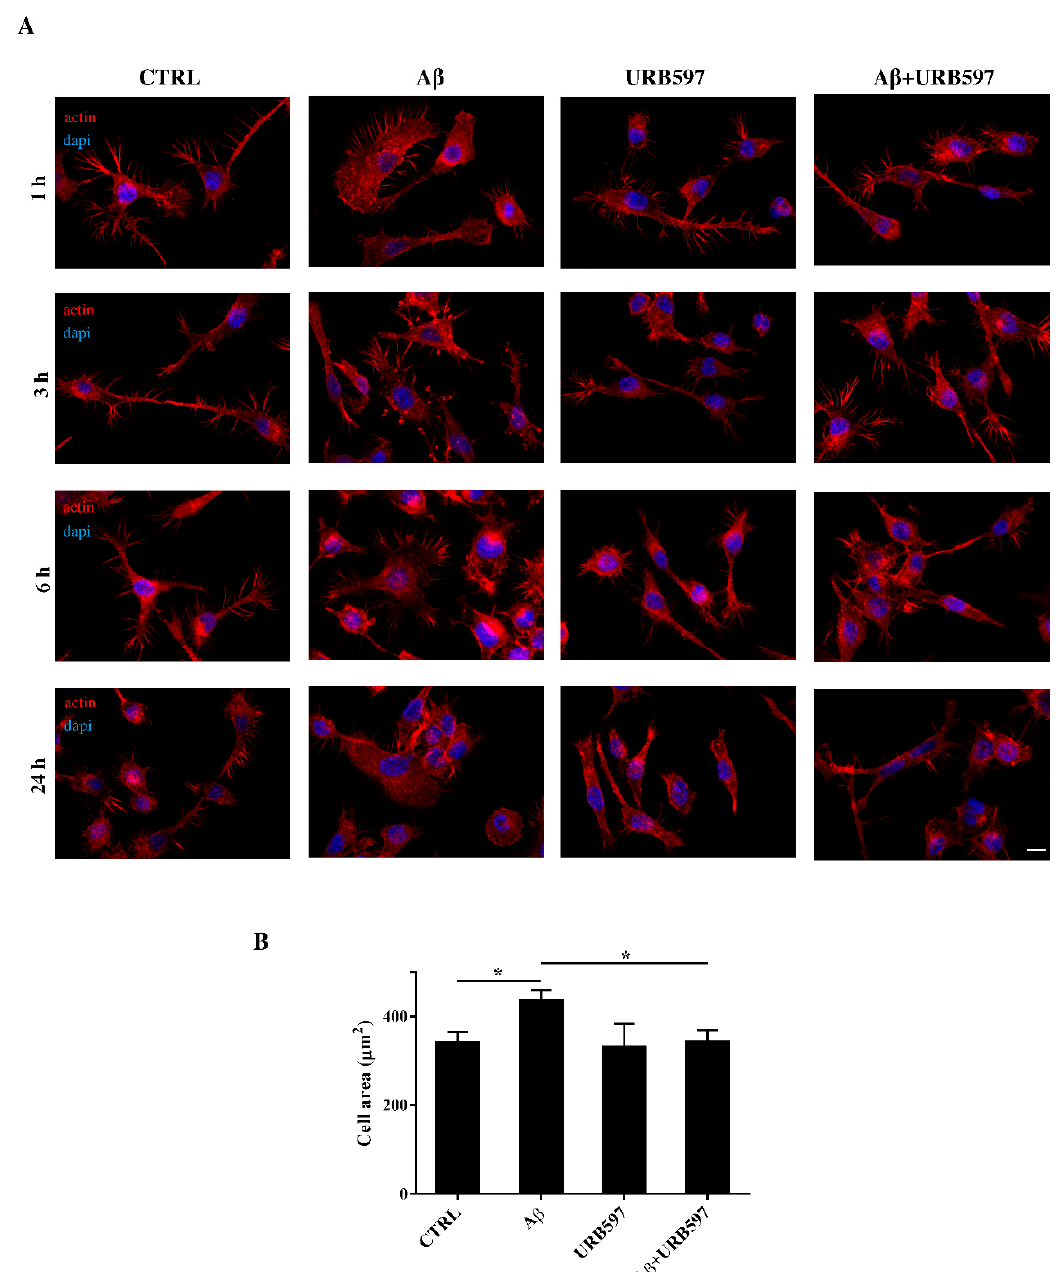
Figure 4. ( A ) Analysis of BV-2 cell morphology by rhodamine-conjugated phalloidin (TRITC-phalloidin) staining to highlight actin and 4 ′ , 6-diamidino-2-phenylindole (DAPI) to detect the nucleus, after pre-treatment with 5 µM URB597 for 4 h and incubated with 30 µM A β 25–35 for 1 h, 3 h, 6 h, and 24 h. ( B ) Cell areas were quantified at 24 h using Image J software. Data were reported as mean ± SD of at least three independent experiments. * p < 0.05. Bar: 20 µm.